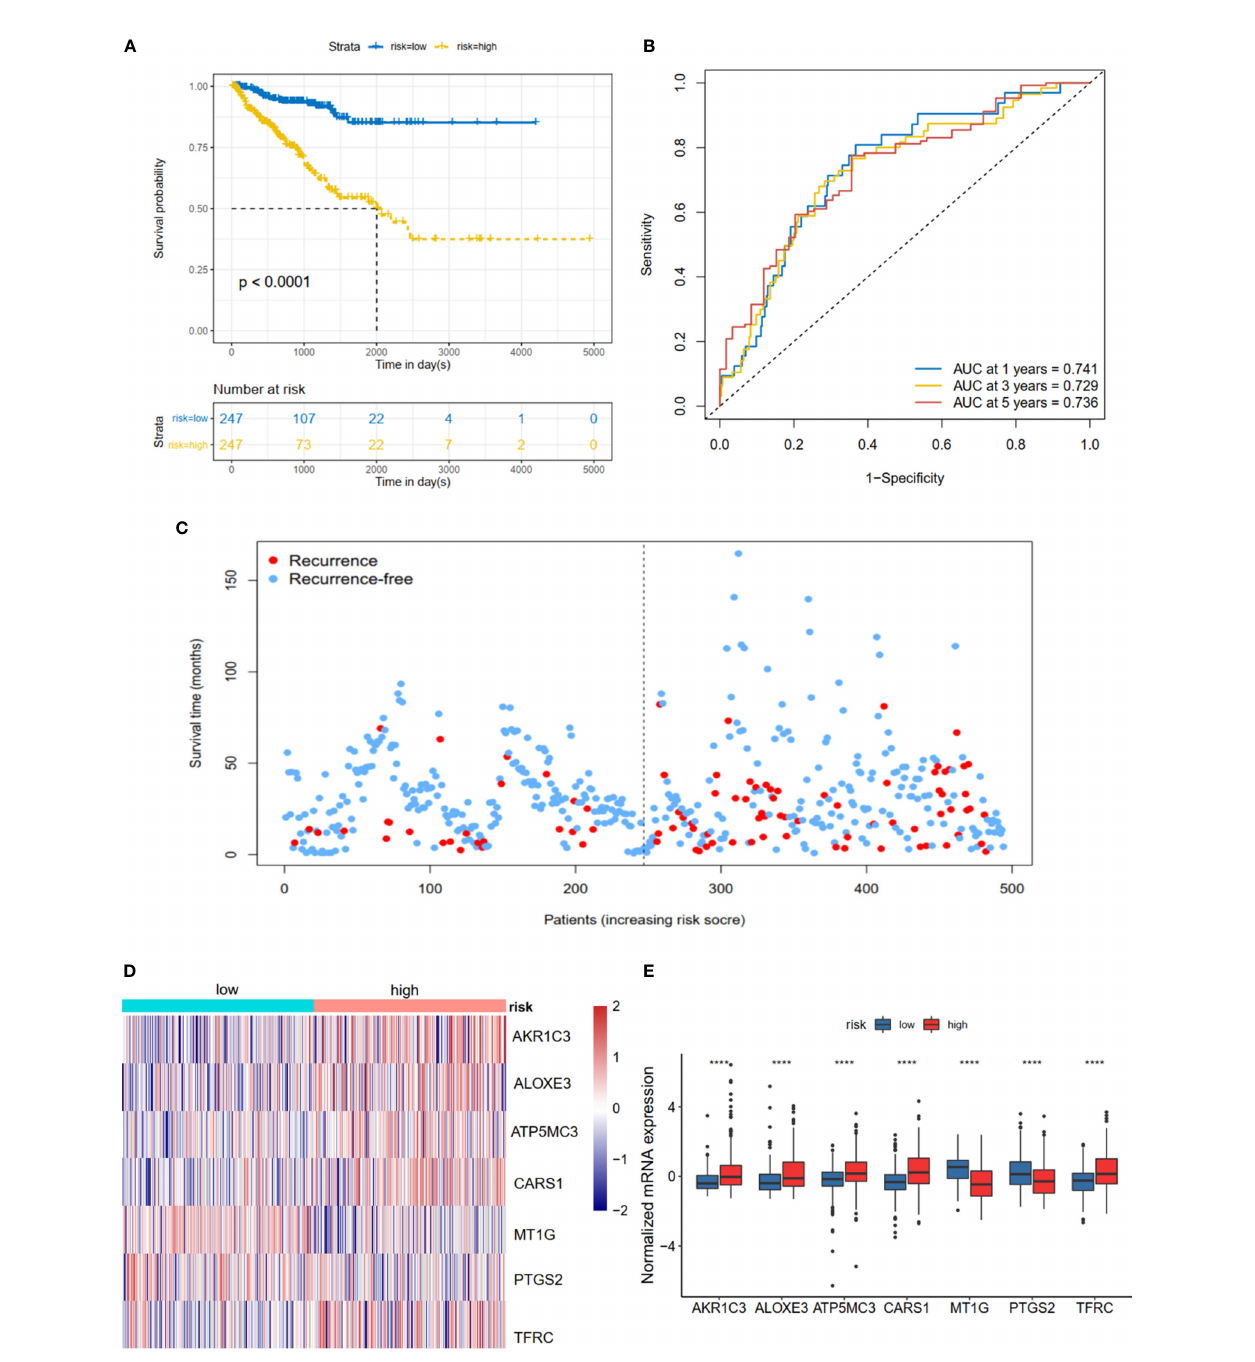
FIGURE 3 | Risk score based on seven hub FRGs in TCGA PRAD cohort. (A) Survival analysis according to risk score. (B) ROC analysis. (C) Survival status of patients. (D, E) Heatmap and barplot of the seven hub genes between high and low risk group. All the survival analysis are based on the recurrence free survival data. ****P <